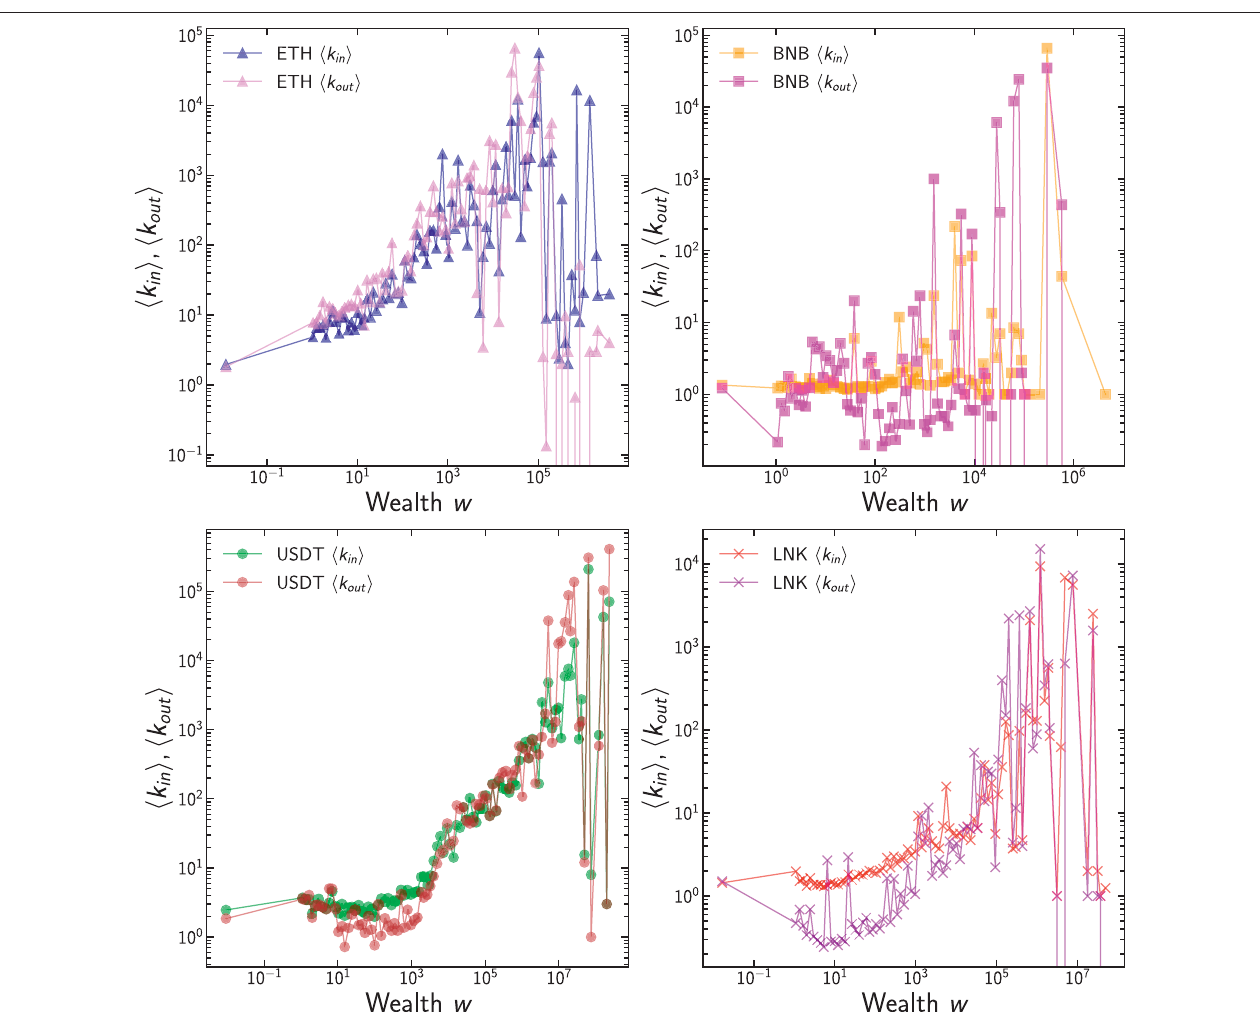
FIGURE 5 | Plot of mean for ETH, BNB, USDT, and LNK. 〈 k in 〉 (in-degree), 〈 k out 〉 (out-degree), 〈 w S 〉 (wealth of the speci fi c token).